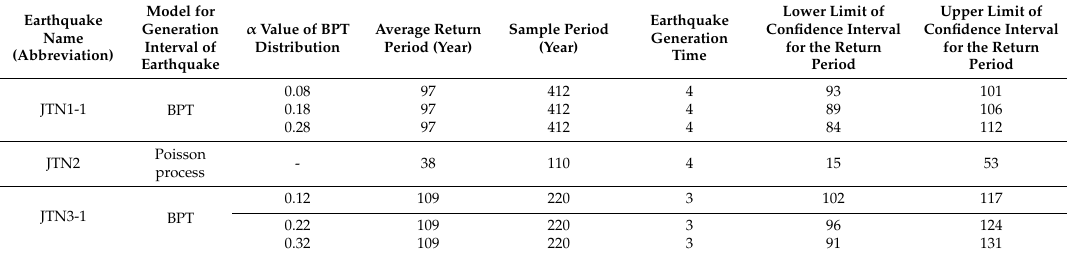
Table 3. Model names for the generation intervals of earthquakes, α values of the BPT distribution, average return periods, sample periods, earthquake generation times within the periods used to determine the average occurrence intervals and lower and upper limits of the confidence intervals for the eleven earthquakes, which are shown in the Headquarters for Earthquake Research Promotion